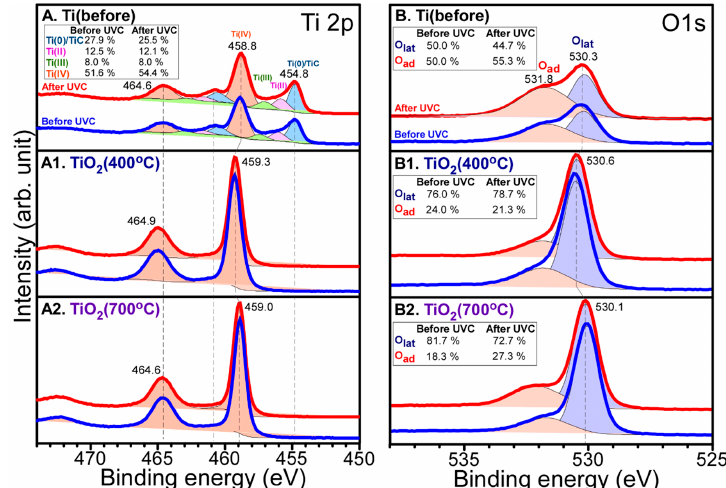
Figure 3. Ti 2p (left column) and O 1s (right column) XPS of: ( A , B ) bare Ti; ( A1 , B1 ) Ti (400 °C); ( A2 , B2 ) Ti (700 °C) before (blue) and after (red) CO 2 reduction. The dot lines are normalized peaks for comparison before and after CO 2 reduction. Inset tables show relative ratios of the deconvoluted peaks.